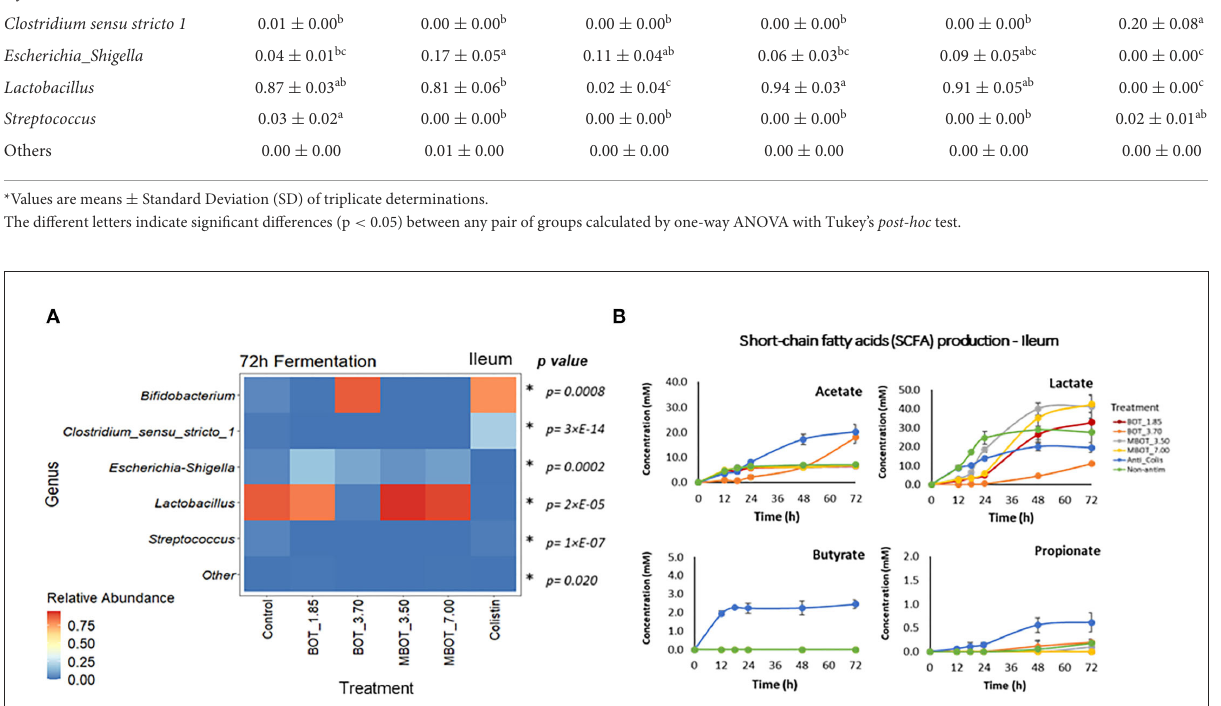
Unknown Genus (even though this was found not